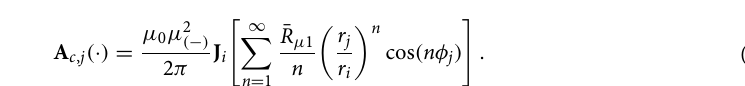
Figure 2. AC losses for multiple (9) MgB 2 wires with the thicknesses of the barrier, SFM, and RE layers labelled in quotation marks. ( a ) shows the metastructured SC wire concept, with the profiles of ( b - d ) J z / J c and ( c - e ) | B | displayed for (1) a conventional-wire, and (9) the optimized metastructured-wire, at the peak transport current I tr = 0.8 I c , and with J c = 1 GA/m 2 as